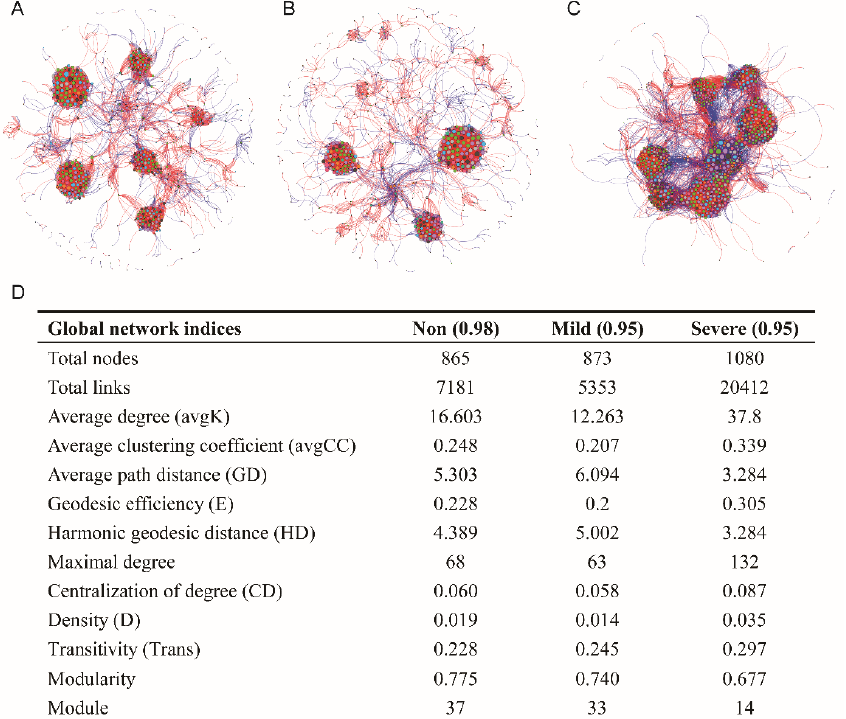
Figure 6. Bacterial network associations ( A : Non–salinity; B : Mild–salinity, C : Severe–salinity) and topological properties of bacterial molecular ecological networks ( D ) of soils with three salinity levels. Network plots were drawn based on random matrix theory (RMT) analysis from OTU profiles. Red and blue lines respectively represent negative and position correlations between nodes. The size of each node is proportional to the number of connections with other nodes in the network.